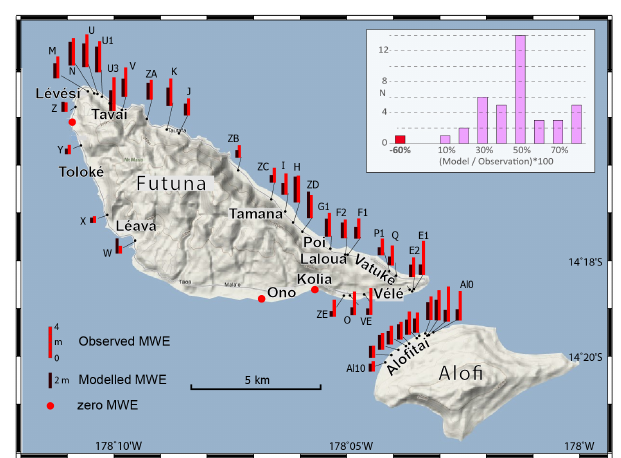
Figure 19. Observed (red) and modelled (black) maximum wave elevations (MWE) at Futuna and Alofi from the 2009 South Pa- cific Tsunami (Observed values from Lamarche et al., 2010). Mod- elled MWEs generated using the Gerris Flow solver. Insert: Mod- elled/observed MWEs expressed in